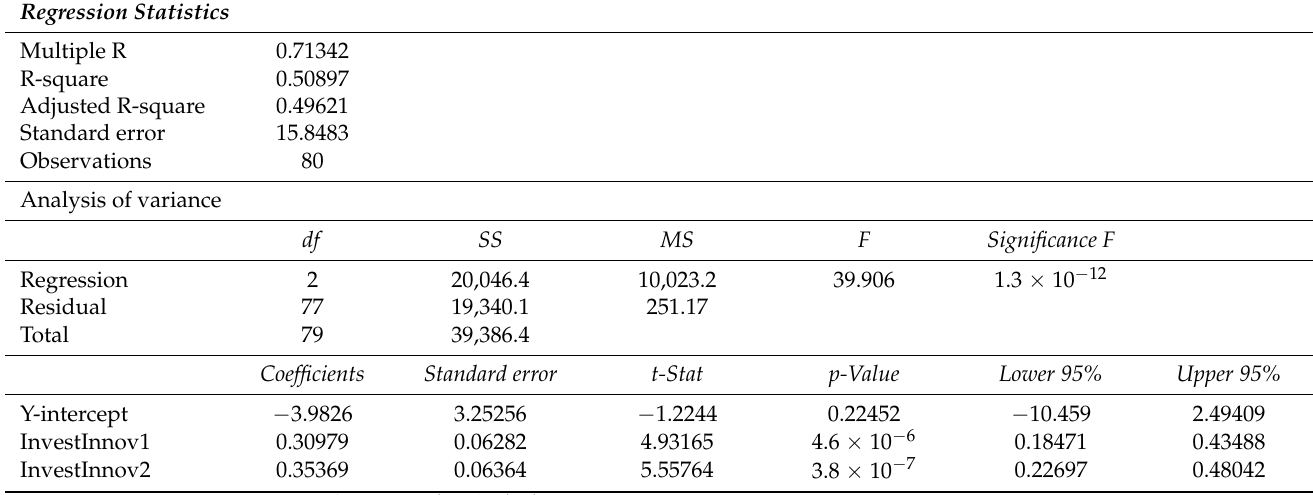
Table A8. Regression statistics of the dependence of Frisk 3 on investments in innovation (InvestIn-